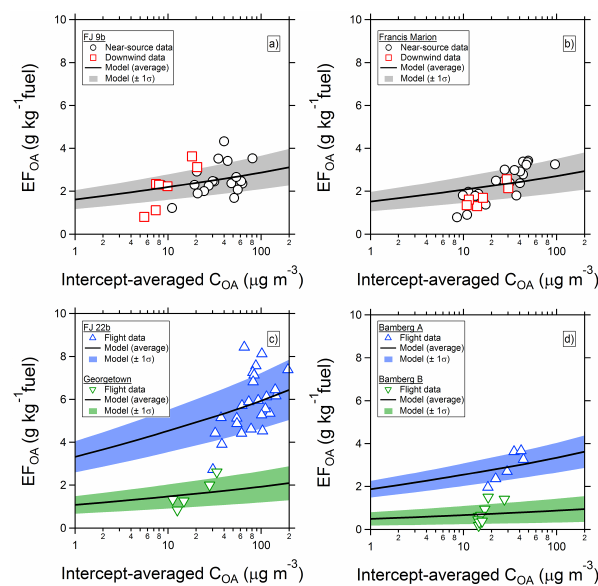
Figure 6. Changes in the emission factor of excess OA due to gas– particle partitioning as a function of total observed OA. (a) Near- source (circles) and downwind (squares) data for the FJ 9b fire; (b) near-source (circles) and downwind (squares) data for the Fran- cis Marion fire; (c) near-source data for the FJ 22b (upward-facing triangles) and Georgetown (downward-facing triangles) fires; and (d) near-source data for the two fires attributed to the Bamberg site (“A”: upward-facing triangles; “B”: downward-facing triangles). Curves represent predictions using the laboratory parameterization from May et al.